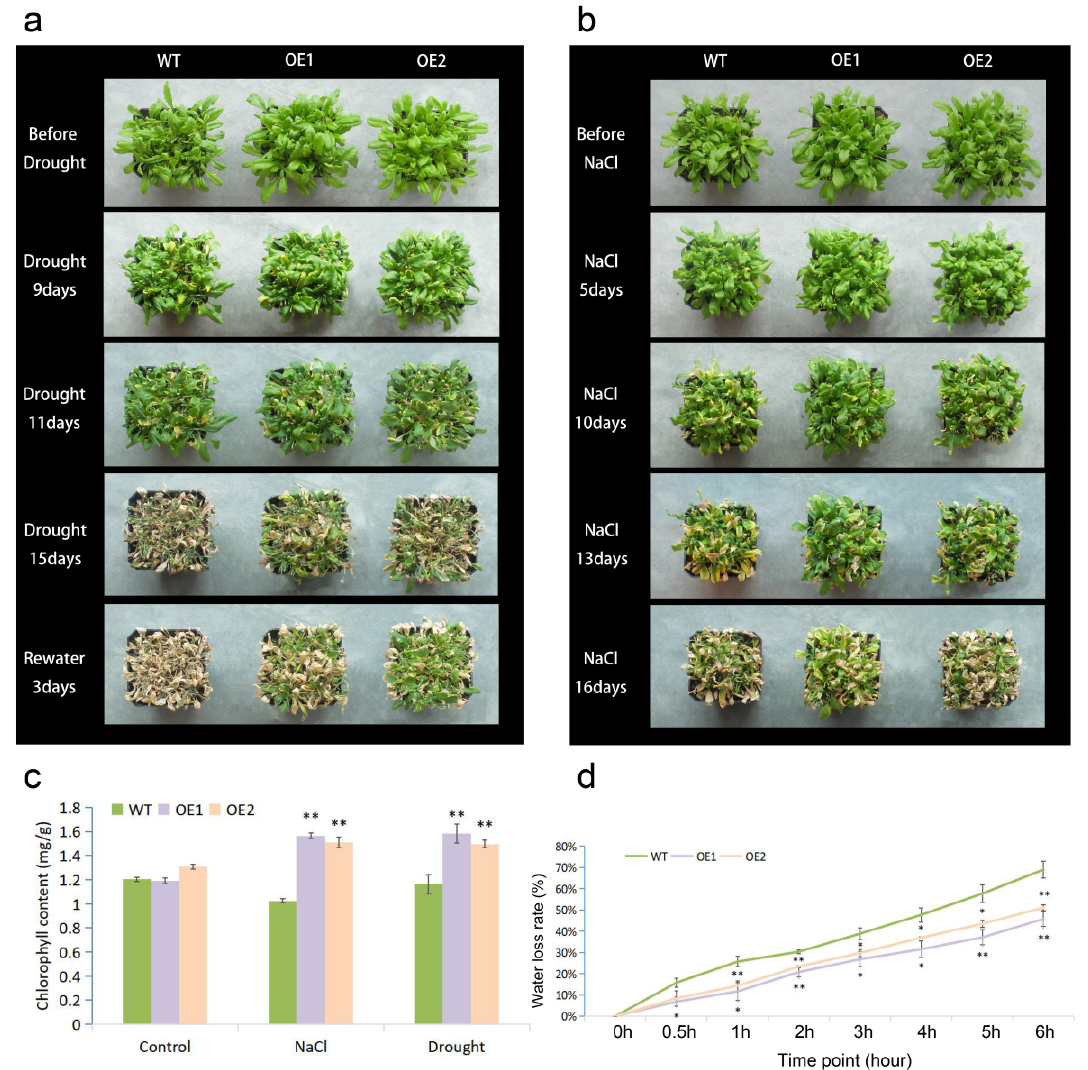
Figure 3. Analysis of drought and salinity tolerance at the adult stage. ( a , b ) showed the growth status of transgenic and WT plants during drought and salinity treatments, ( c , d ) showed measurements of chlorophyll content and water loss rate, respectively. The error bars are SDs, and the asterisk indicates a significant difference (* p < 0.05; ** p < 0.01) .